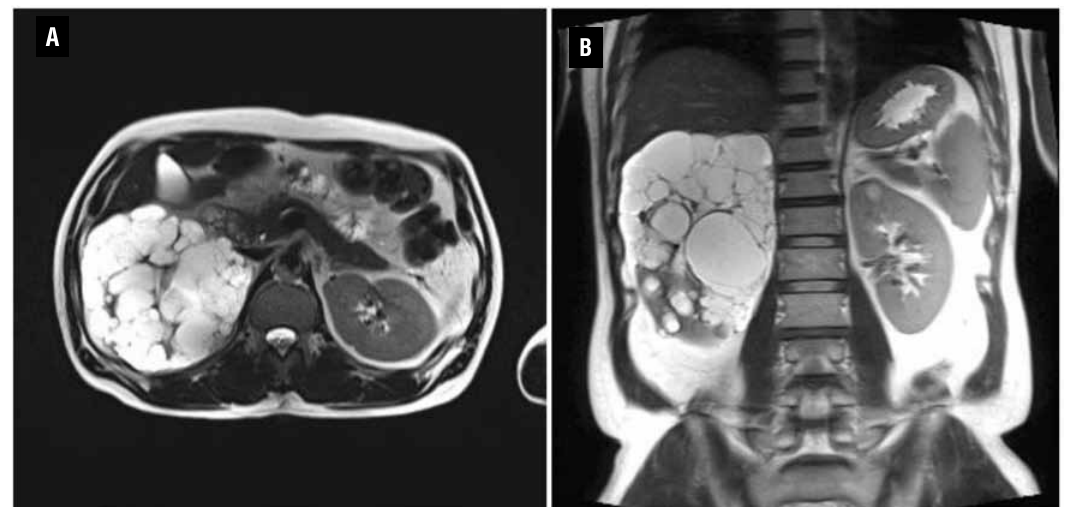
Figure 2 - Postoperative axial (A) and coronal scan (B) of the kidney MRI (T2 weighted image) showing multiple cysts in the right